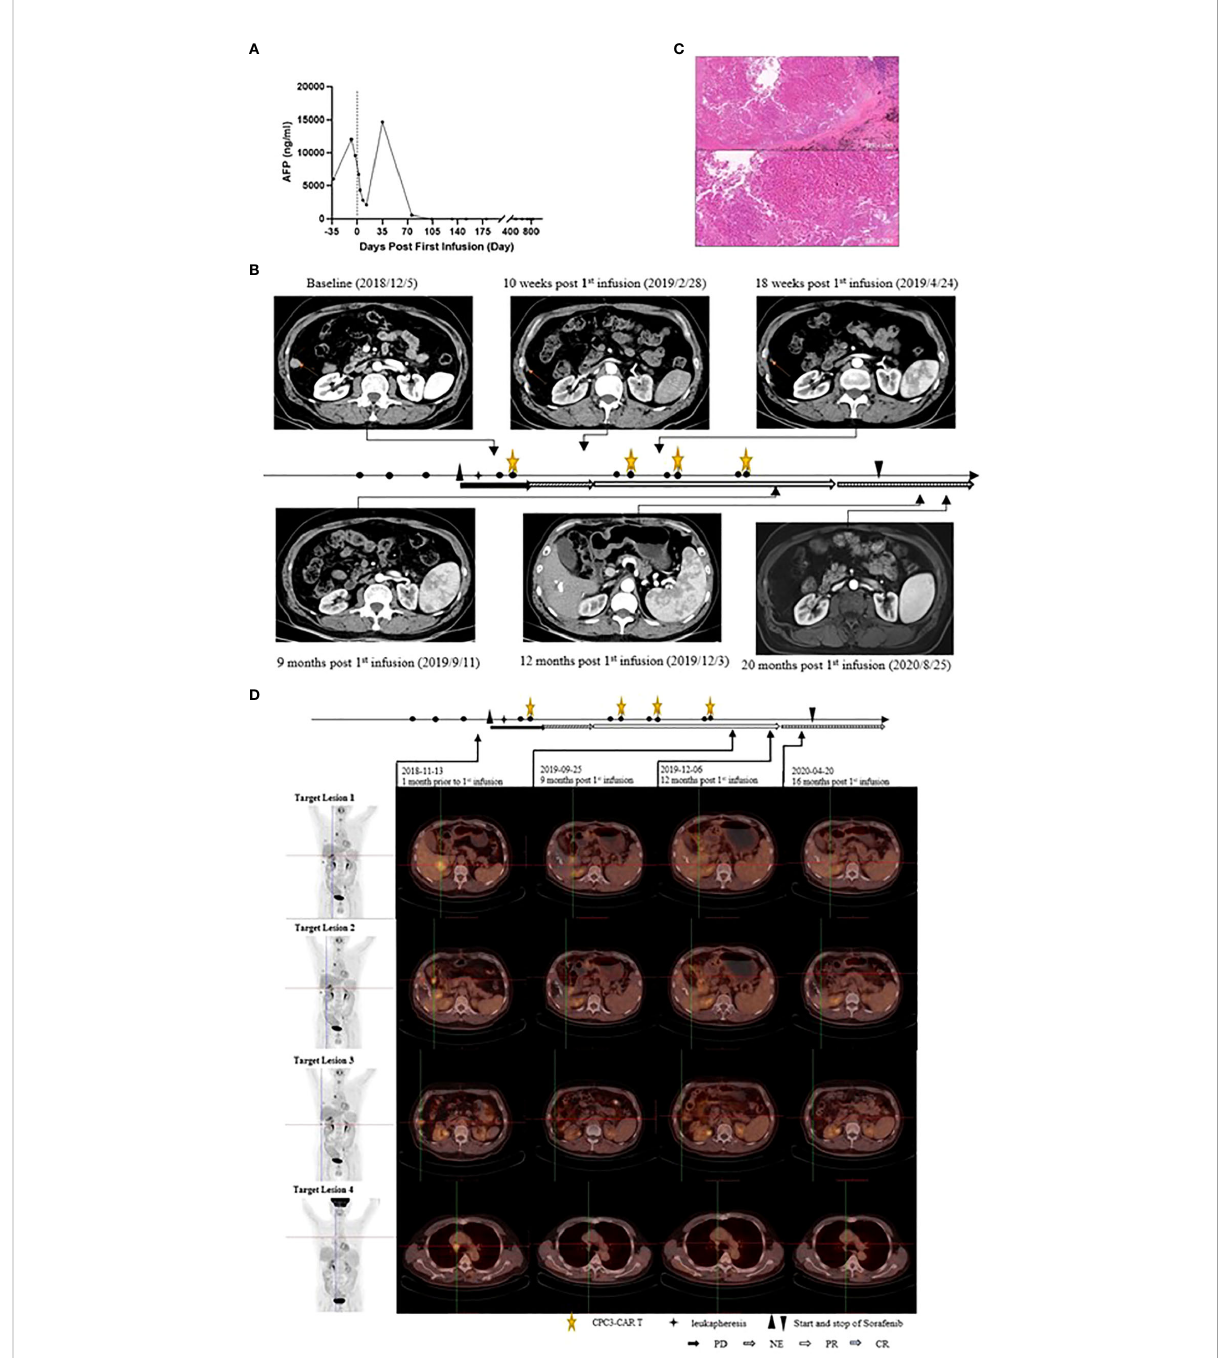
FIGURE 3 Ef fi cacy of the combination of Sorafenib plus CT011 with lymphodepletion. (A) , Changes of the AFP after Sorafenib monotherapy and the initiation of GPC3-CAR T infusion; (B) , Changes of the No.3 target lesion. CT scans showed this target lesion was about 16.76 mm at baseline and regressed gradually after the combination treatment. At 9 th month, this lesion completely disappeared without relapse; (C) , The postoperative pathology picture of the No.4 target lesion at 12th month (HE×100 and HE×200, the pictures showed large patch of coagulative necrosis, peripheral fi brosis, chronic in fl ammatory cell in fi ltration, no obvious tumor residue, indicating reaction post anti-tumor treatment); (D) , Positron emission tomography-computed tomography (PET-CT) images of the target lesions. The patient received PET-CT check at baseline, 9 months, 12 months, and 16 months post fi rst infusion. No.1, No.2 and No.3 target lesions disappeared at the 12 th month, while No.4 target lesion was inactive and was considered as non-speci fi c uptake after anti-tumor